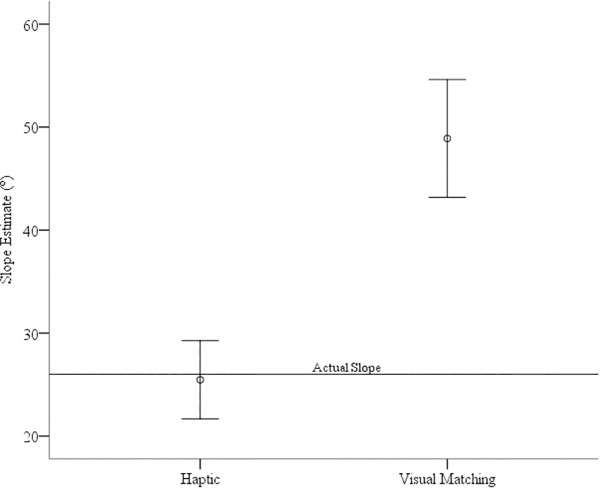
Estimates of slope for the haptic and visual matching tasks.The line represents the actual slope. Error bars represent 95% CIs.